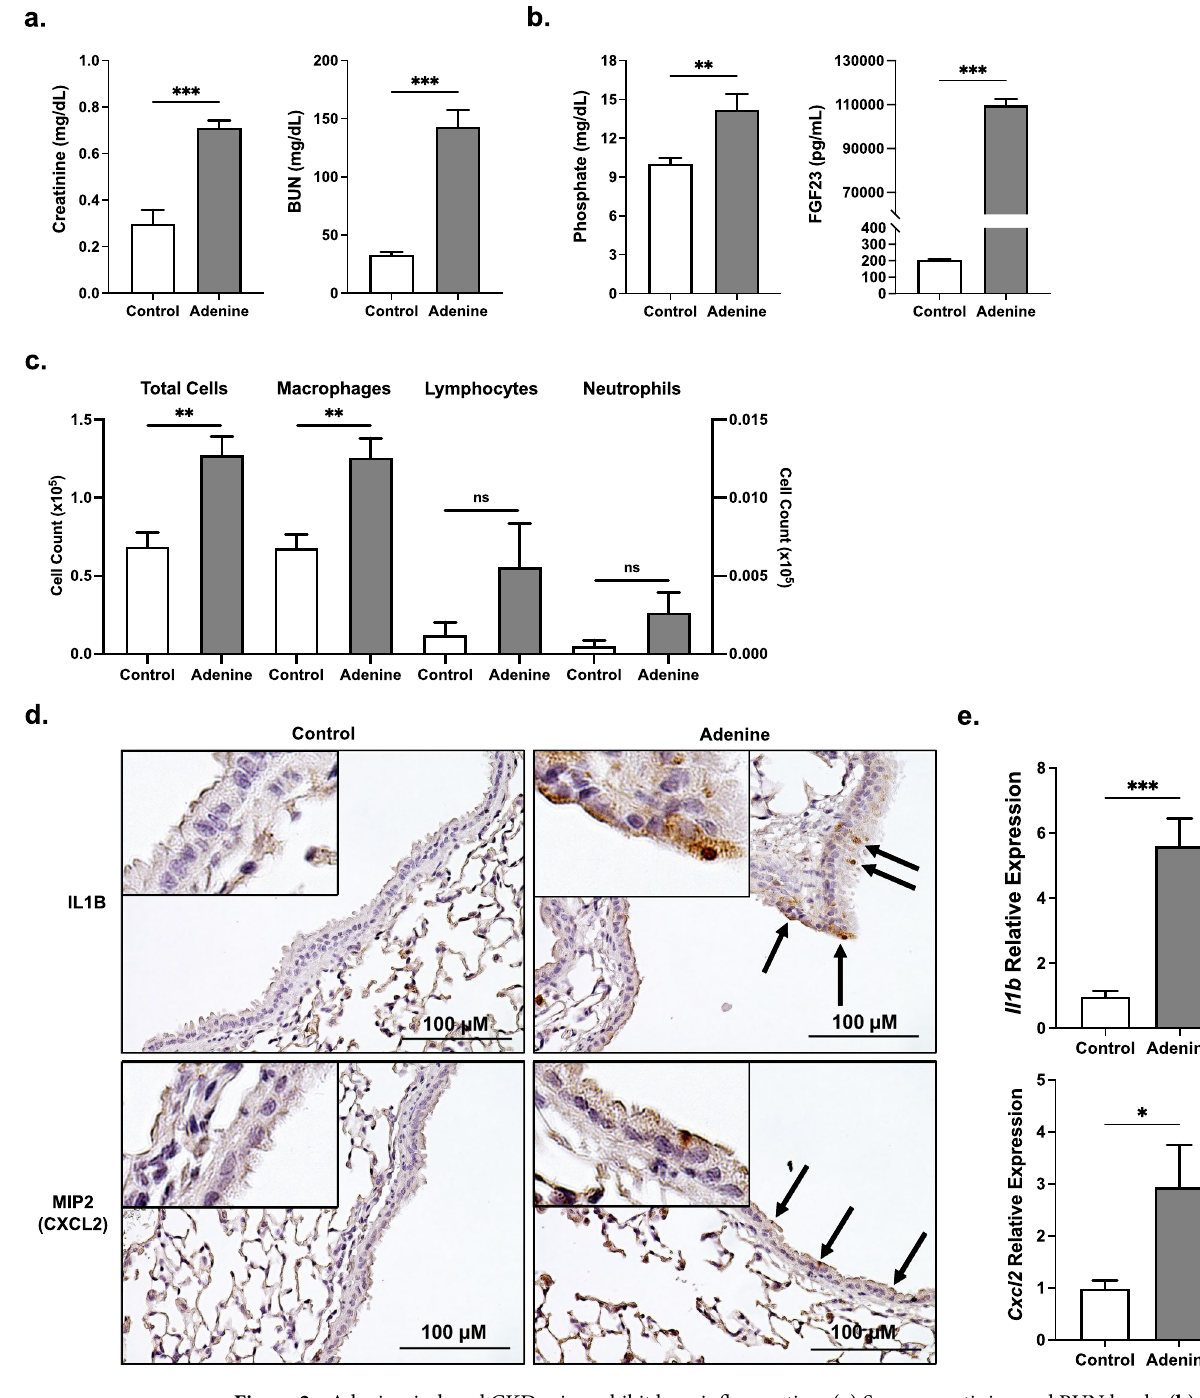
Figure 2. Adenine-induced CKD mice exhibit lung inflammation. ( a ) Serum creatinine and BUN levels, ( b ) serum phosphate and FGF23 levels, and ( c ) total cell count and macrophage, lymphocyte, and neutrophil counts from BAL fluid of mice on the adenine diet and littermates on the control diet. Left y-axis applies to total cell and macrophage count; right y-axis applies to lymphocyte and neutrophil count. ( d ) Representative pathology of IL1B and CXCL2 IHC-stained lung sections (scale bar, 100 µM) from mouse lungs of both groups. ( e ) Relative mRNA transcript levels of Il1b and Cxcl2 in total mouse lung homogenates. All values are mean ± SEM with *p ≤ 0.05, **p < 0.01, and ***p < 0.001 and n = 10 mice/group. Statistical significance was analyzed via unpaired Student’s t -test ( a – e